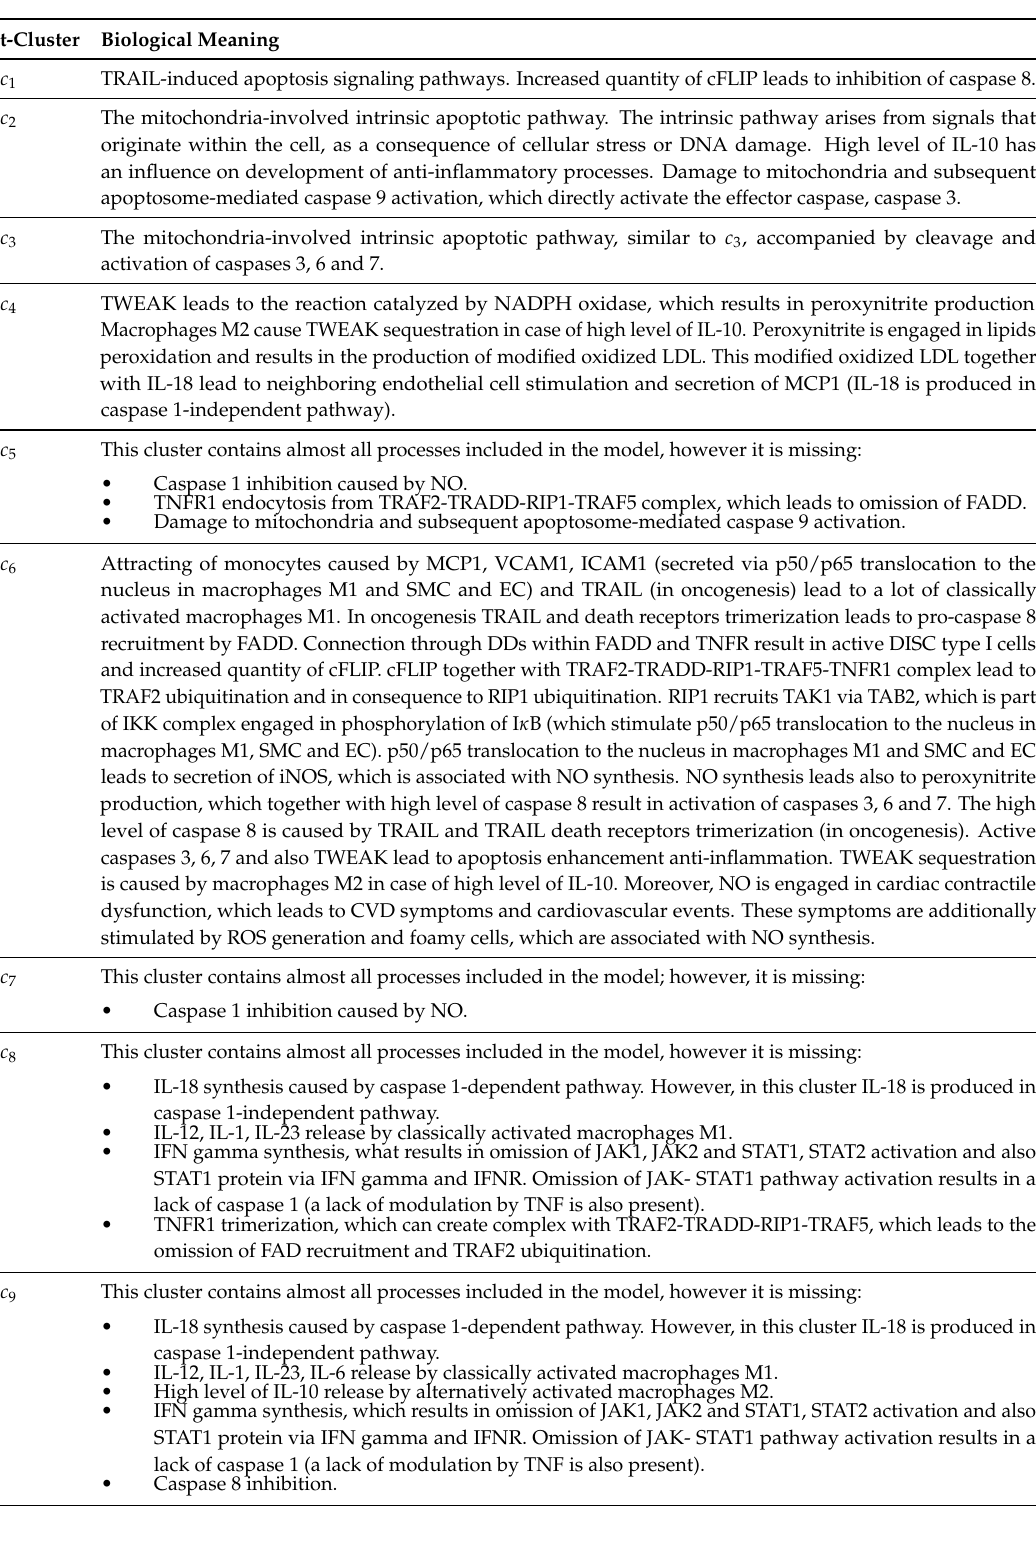
Table 2. List of t-clusters. The column “t-cluster” contains the names of t-clusters. The column “Biological meaning” includes biological interpretations of